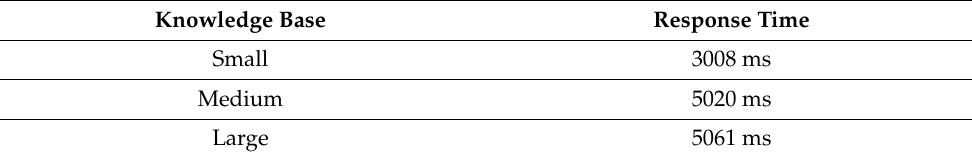
Table 7. Performance evaluation